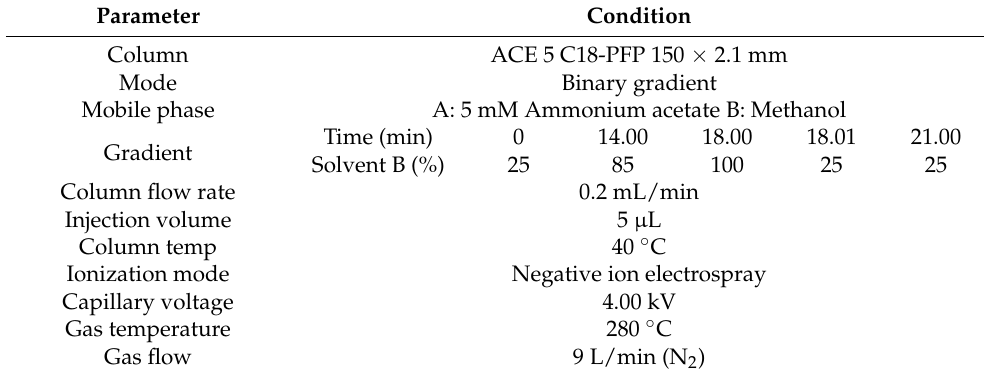
Table 1. Instrument conditions.